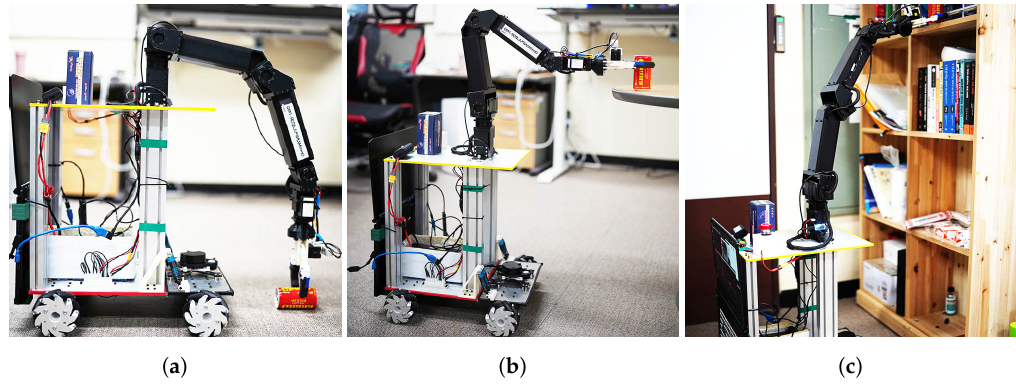
Figure 10. Parameterized arm motions realized with MSR-1. ( a ) Low height, vertical grasp, ( b ) Low height, horizontal grasp and ( c ) High height, horizontal